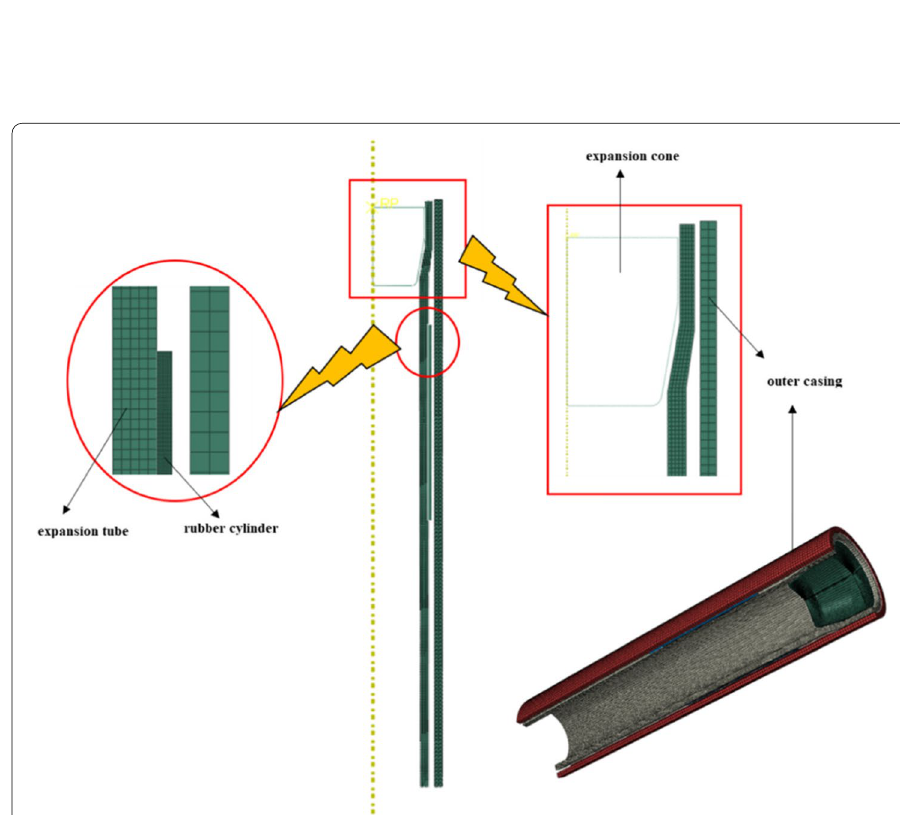
Fig. 3 Finite element mesh model of expanded liner with rubber